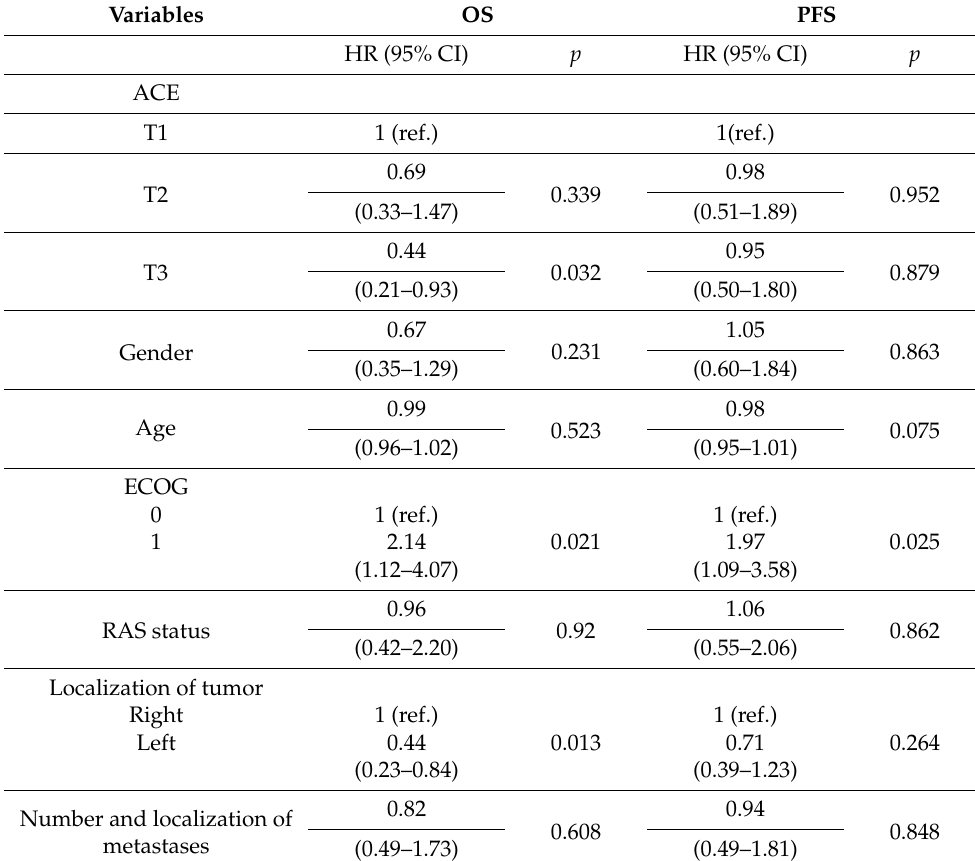
Table 3. Multivariate analysis of OS and PFS including tertiles of